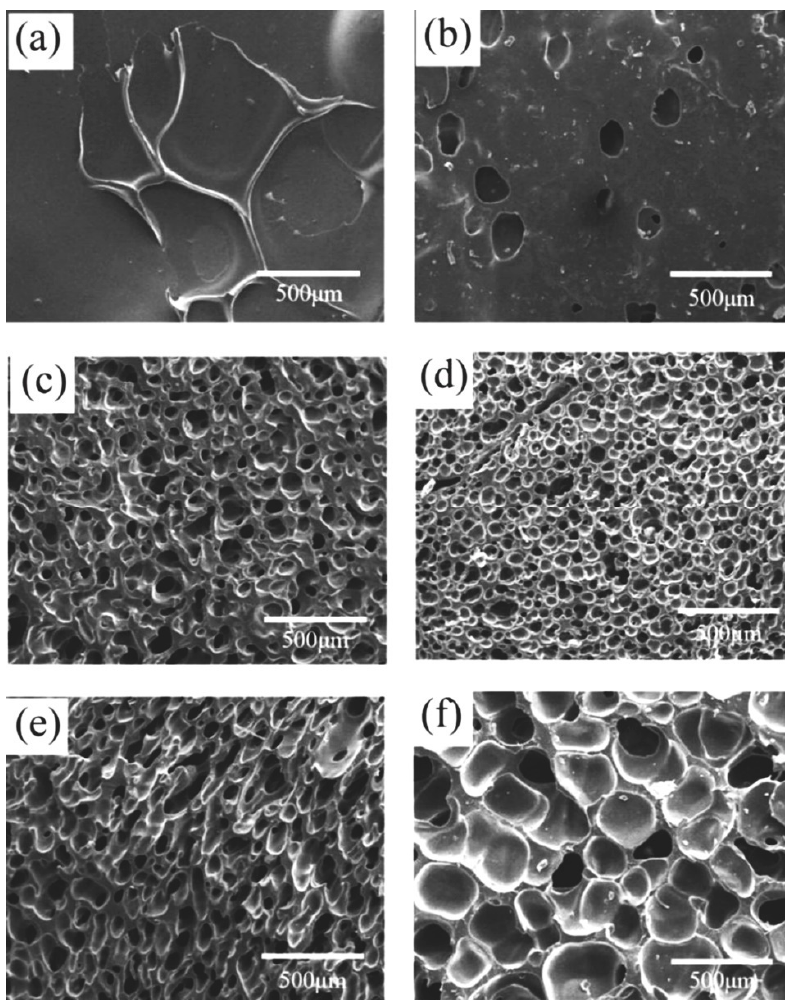
Figure 7. Cell morphology of foamed samples with different CO 2 saturation times: ( a ) 30 min; ( b ) 60 min; ( c ) 90 min; ( d ) 120 min; ( e ) 150 min; ( f ) 180 min. Table 3. Parameters of foamed samples with different CO 2 saturation times.